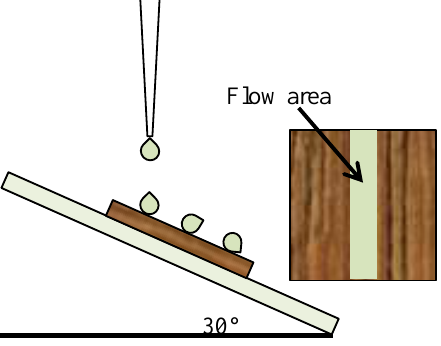
Figure 1. Schematic diagram of water resistance test for superhydrophobic wood.